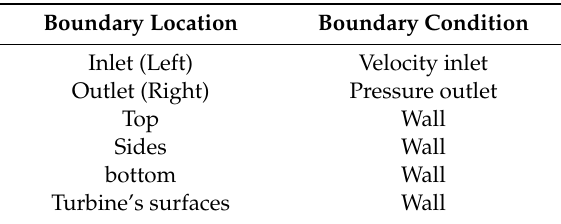
Figure 9. Boundary conditions. Table 1. Boundary conditions. Table 1. Boundary conditions.